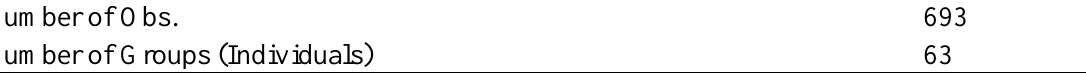
Table A3. Random effects tobit estimation with Type Y data for Treatments CH1 and CH2. Number of